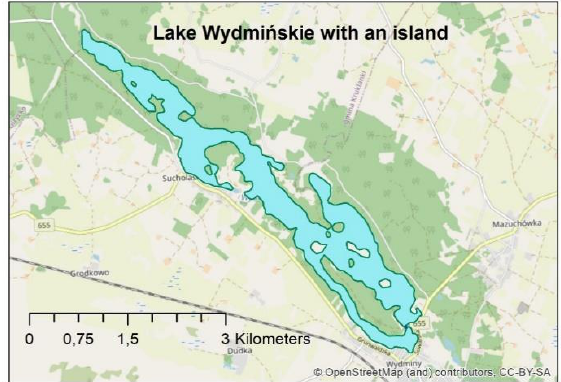
Figure 22. Lake Wydmińskie with numerous islands.